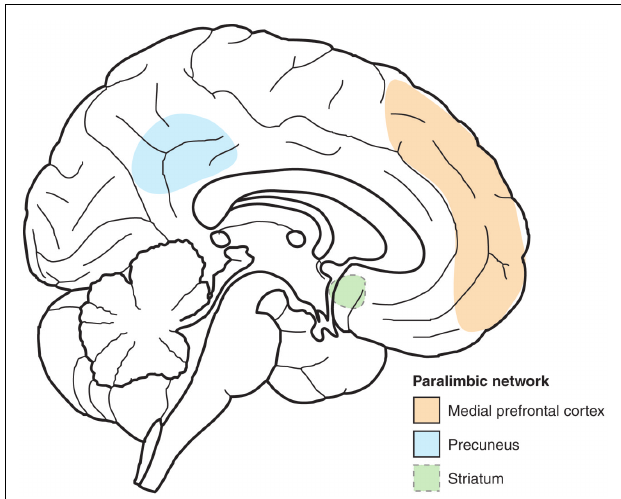
FIGURE 1 | Sketch of the paralimbic network. Principal component analysis was used to identify brain regions common to conscious experiences during yoga-nidra meditation and the normal resting conscious state.Two major clusters were found, explaining 25 and 18% of the variability.The paralimbic network consists of a set of three regions which contributed to both clusters: Striatum, medial prefrontal, and medial parietal cortices (precuneus). Being active in a wide variety of conscious experiences, we hypothesize that this paralimbic network represented self-reference, as a common denominator for conscious experiences to account for a sense of unity of consciousness.